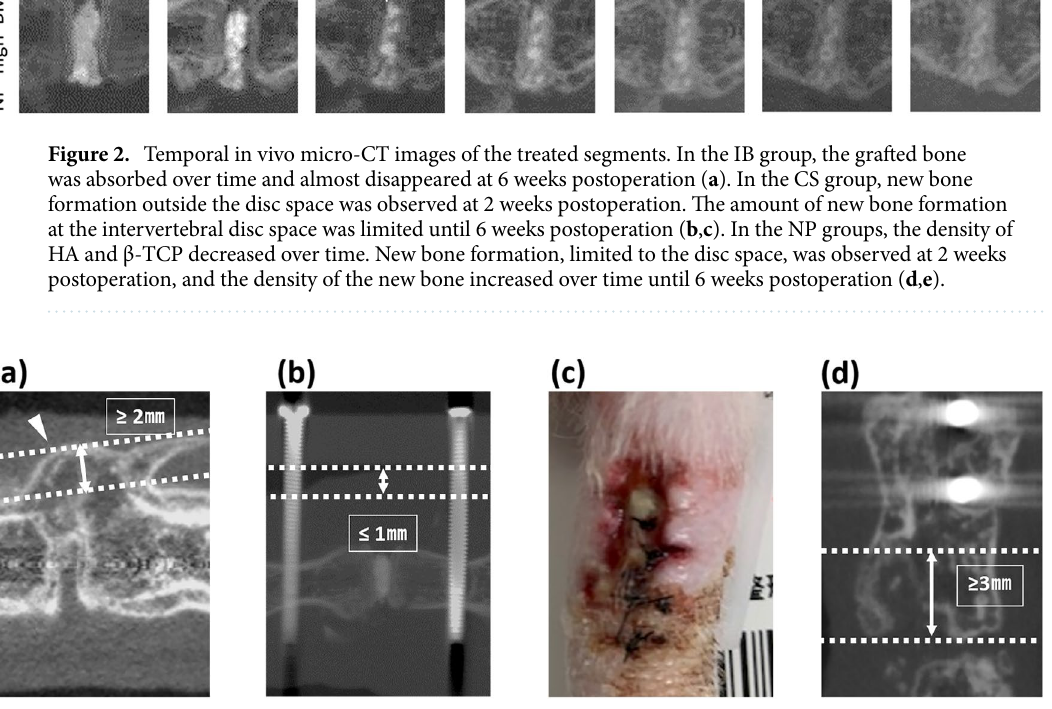
The swelling ratio of the NP groups was not affected by the BMP-2 dose, in contrast to the CS groups, in which the swelling ratio was increased when combined with high-dose BMP-2 (Fig. 4b). Histological analysis. In the IB group, the intervertebral disc space was predominantly composed of fibro- cartilage tissue. In the CS-low BMP group, only a small amount of new bone formation was observed in the